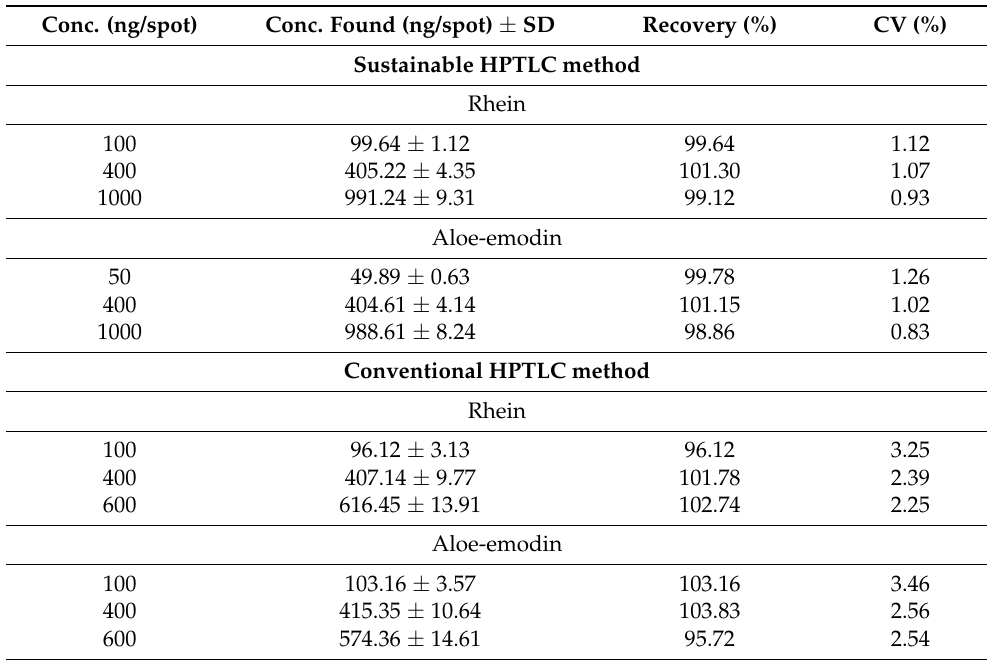
Table 3. Accuracy data of rhein and aloe-emodin for the sustainable and conventional analytical assays (mean ± SD; n =